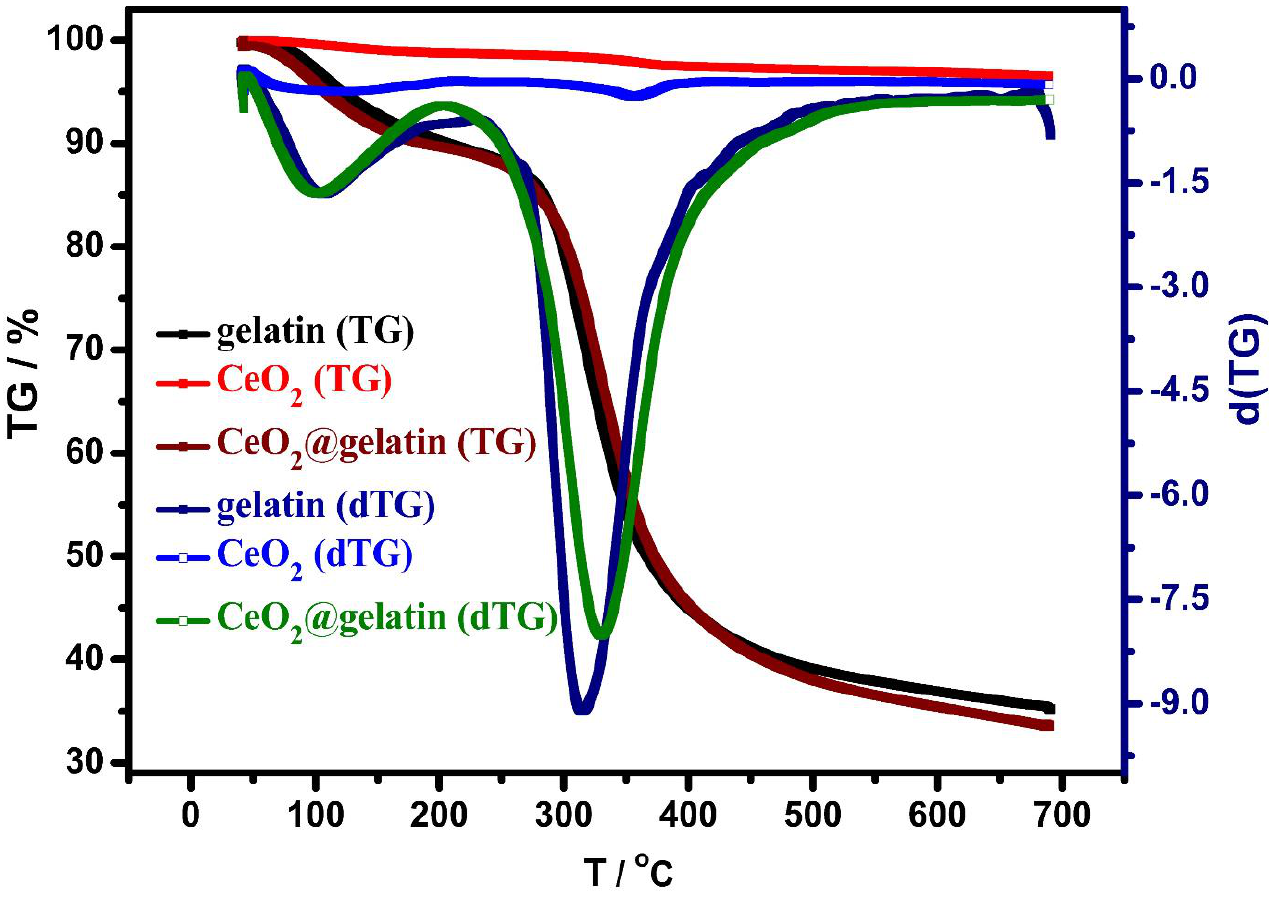
Figure 5. TGA analyses of gelatin, CeO 2 , and 5% CeO 2 @gelatin samples and their dTG analysis.